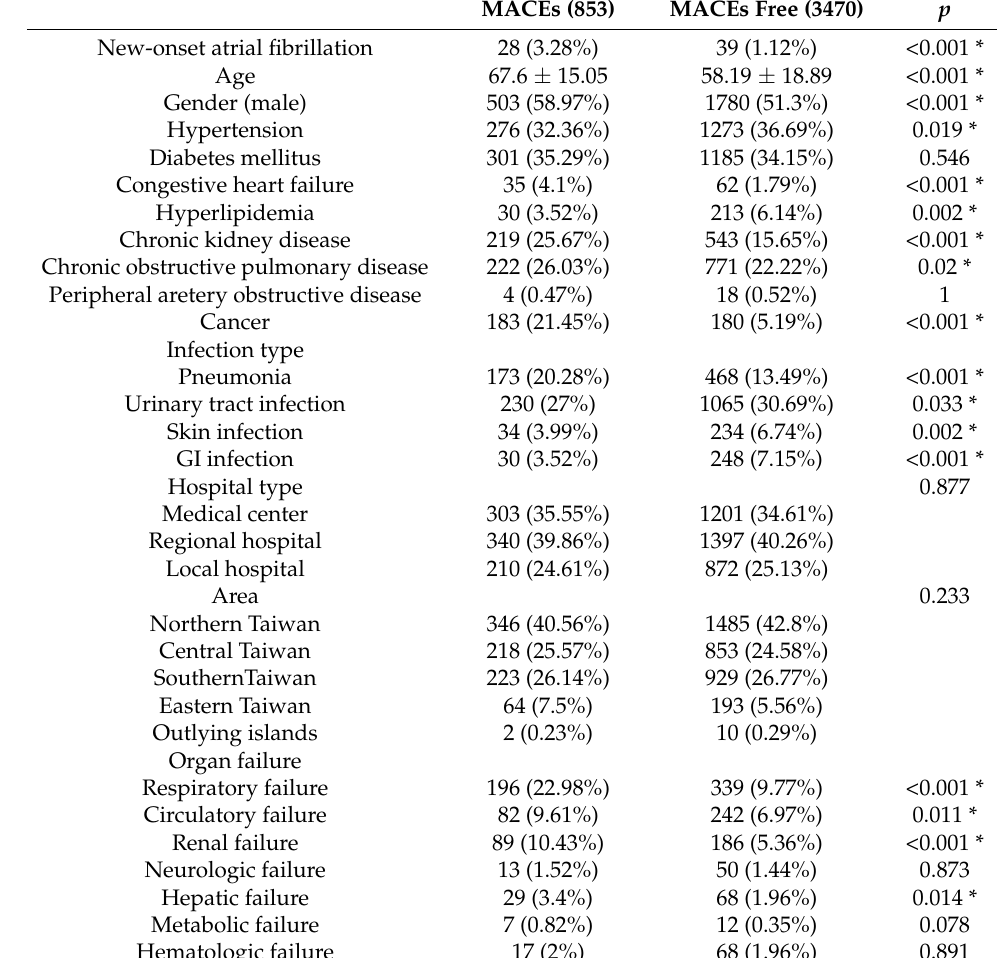
Table 1. Baseline characteristics of the study subjects.